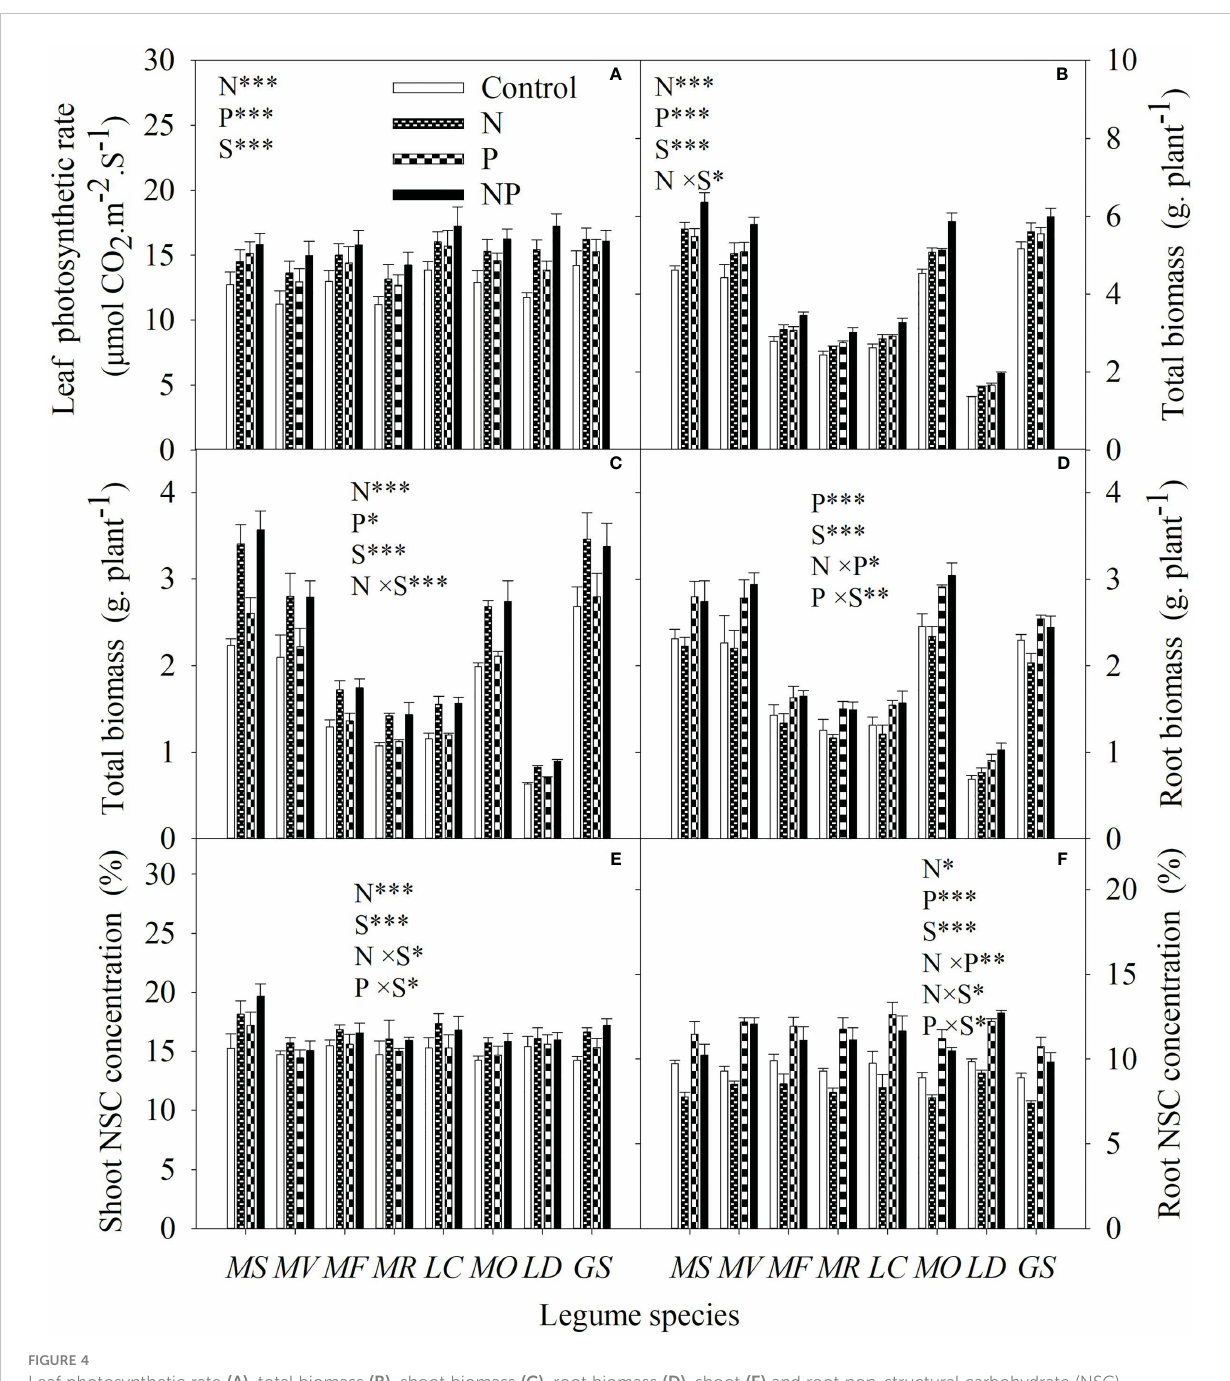
FIGURE 4 Leaf photosynthetic rate (A) , total biomass (B) , shoot biomass (C) , root biomass (D) , shoot (E) and root non-structural carbohydrate (NSC) concentration (F) under control (no fertilizer addition), N (N addition), P (P addition) and NP (addition of both N and P) for eight legume species. MS, Medicago sativa ; MV, Medicago varia ; MF, Medicago falcata ; MR, Medicago ruthenica ; LC, Lotus corniculatus ; MO, Melilotus of fi cinalis ; LD, Lespedeza daurica ; GS, Glycine soja. Letters (N, P, S, N×P, N×S, P×S, N×P×S) indicate signi fi cance overall from N addition, P addition, legume species (S) and their interaction effects according to general linear model P-values, the signi fi cance level are reported as ***(P<0.001), **(P<0.01), *(P<0.05). Inside the embedded fi gures, the bars represent the means of each independent factor and interacted treatment with signi fi cant